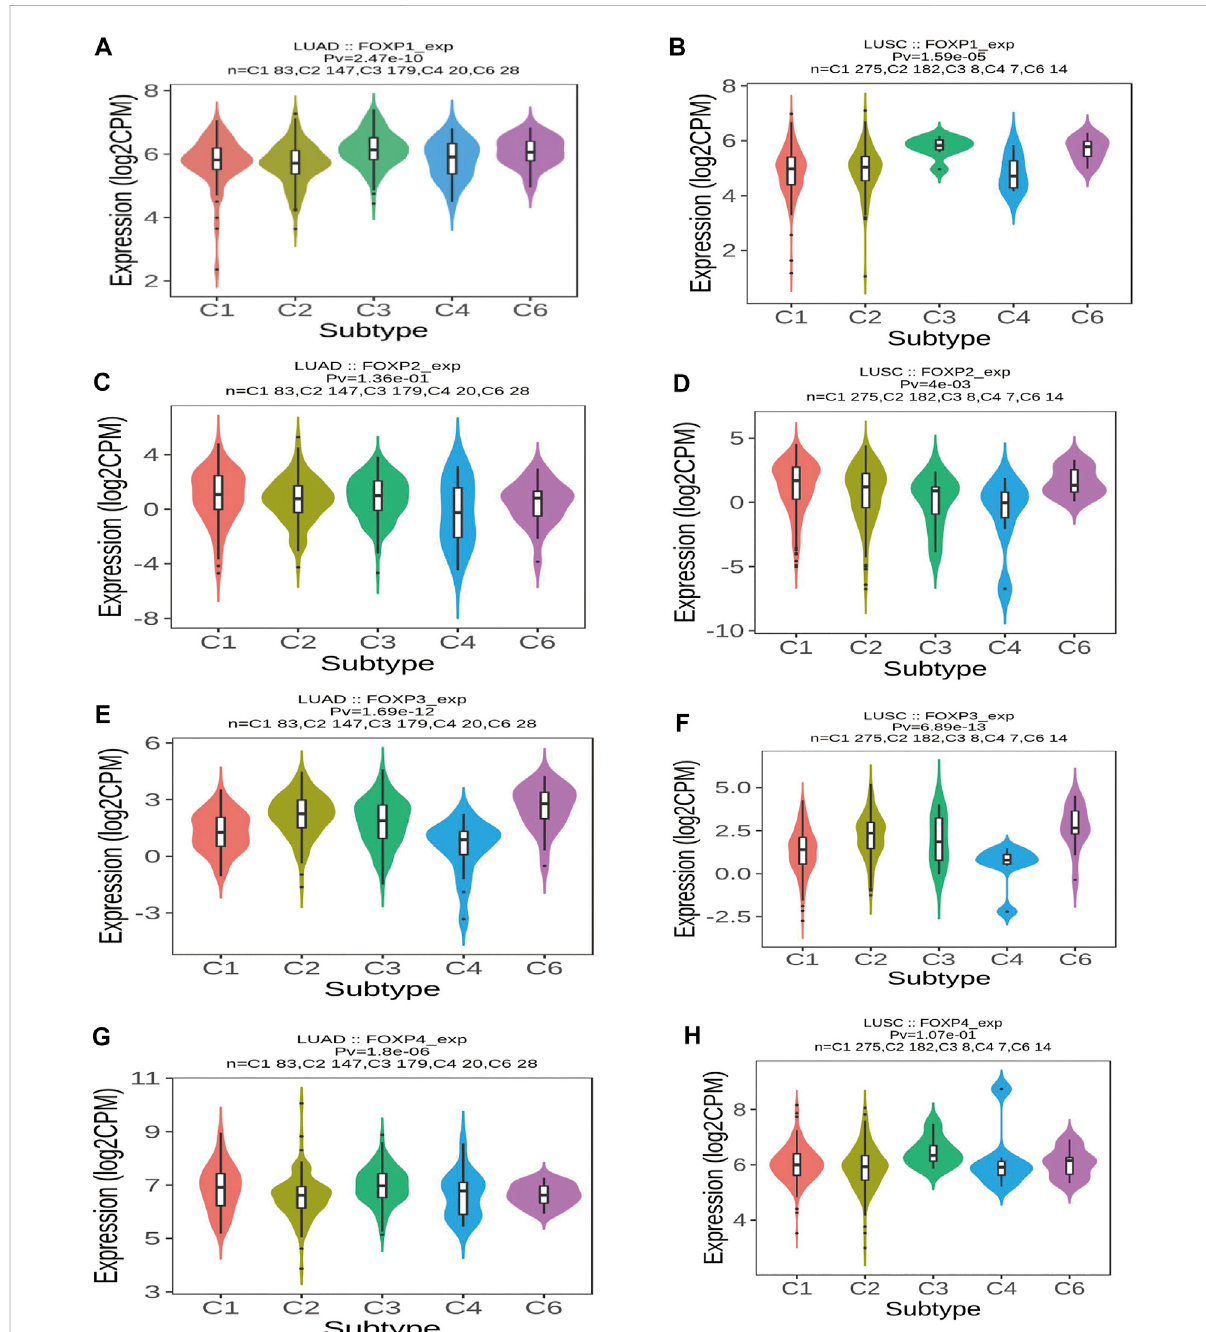
FIGURE 12 The relationship between immune types and the FOXP family. (A) The violins plot showed statistical relationships between FOXP1 and immune types C1 – C6 in LUAD. (B) The violins plot showed statistical relationships between FOXP1 and immune types C1 – C6 in LUSC. (C) The violins plot showed statistical relationships between FOXP2 and immune types C1 – C6 in LUAD. (D) The violins plot showed statistical relationships between FOXP2 and immune types C1 – C6 in LUSC. (E) The violins plot showed statistical relationships between FOXP3 and immune types C1 – C6 in LUAD. (F) The violins plot showed statistical relationships between FOXP3 and immune types C1 – C6 in LUSC. (G) The violins plot showed statistical relationships between FOXP4 and immune types C1 – C6 in LUAD. (H) The violins plot showed statistical relationships between FOXP4 and immune types C1 – C6 in LUSC. [C1 (wound healing); C2 (IFN-gamma dominant); C3 (in fl ammatory); C4 (lymphocyte depleted); C5 (immunologically quiet); C6 (TGF-b